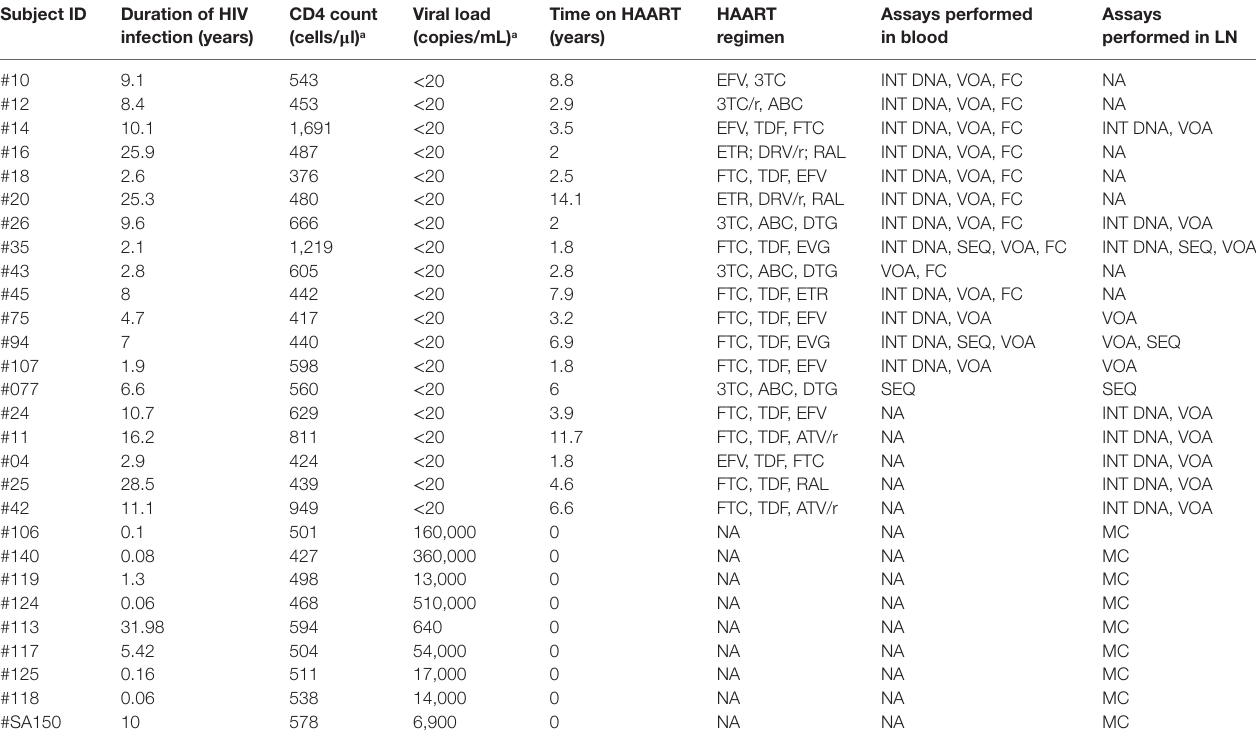
TaBle 1 | Characteristics of study